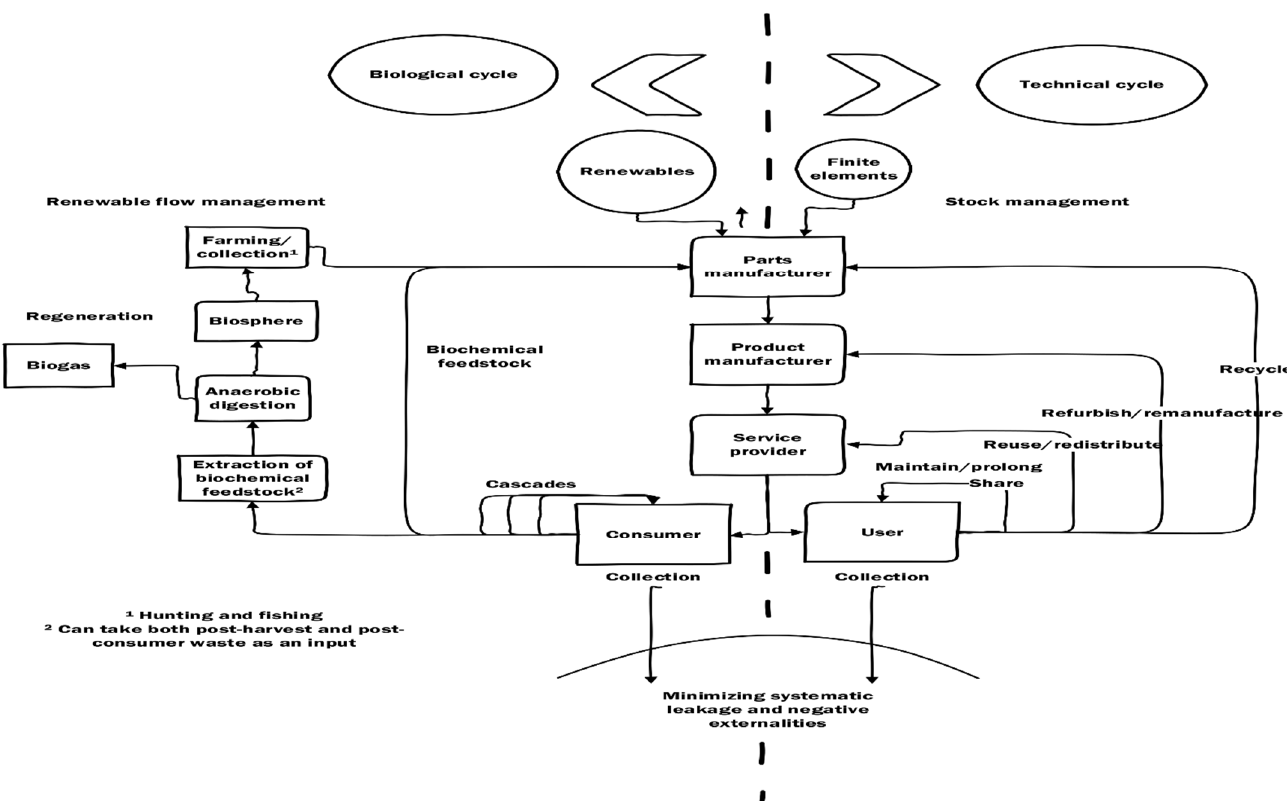
Figure 1. Circular economy—an industrial system that is restorative and regenerative by design, redrawn and adapted from [12] .